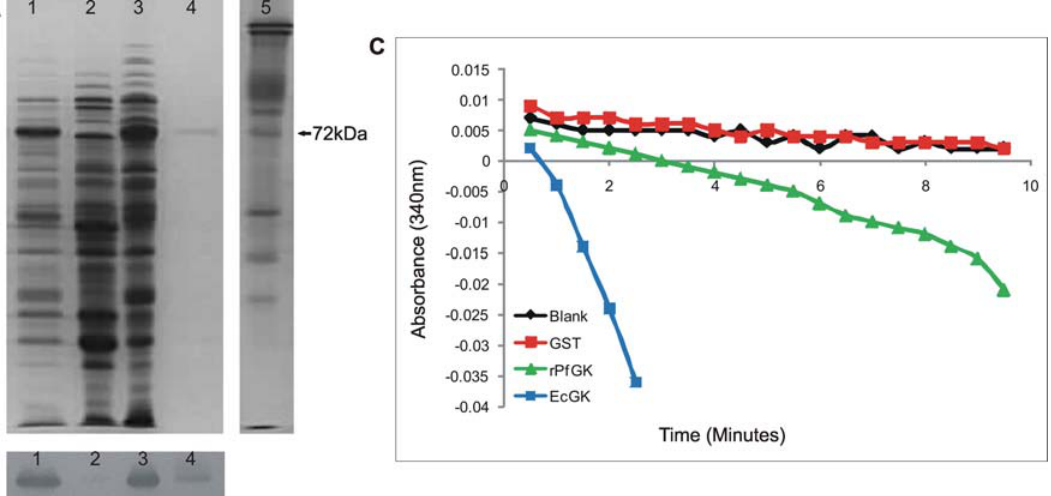
Figure 5. rPfGK purification and enzyme activity. (A) SDS PAGE analysis and (B) immunoblot analysis showing the expression and affinity purification of rPfGK from the soluble protein fraction of E. coli cells. Lane 1: total E. coli protein, Lane 2: soluble protein fraction, Lane 3: insoluble protein fraction, Lane 4: purified rPfGK, Lane 5: red cell membrane marker. (C) The oxidation of NADH to NAD + in the glycerol kinase coupled enzyme reaction measured at 340nm shows active rPfGK (green) compared to the blank (black), negative control GST (red) and the positive control EcGK (blue).